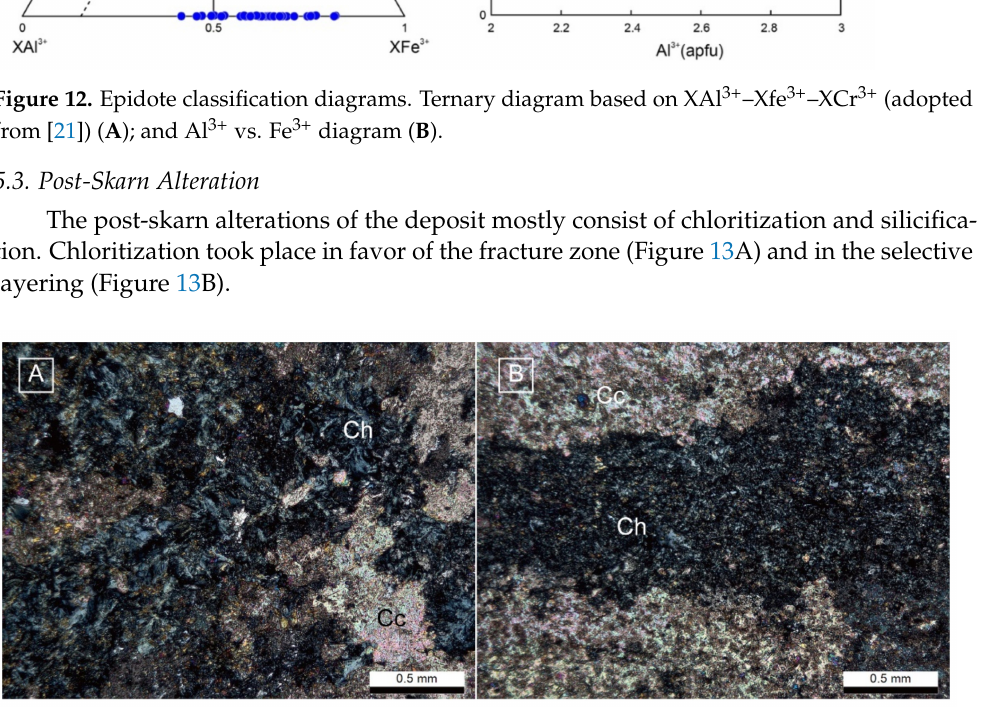
Figure 13. Microphotographs of the chloritized epidote skarn. ( A ) Fracture-filling chlorite (Ch) in the amphibole skarn. ( B ) Chlorite